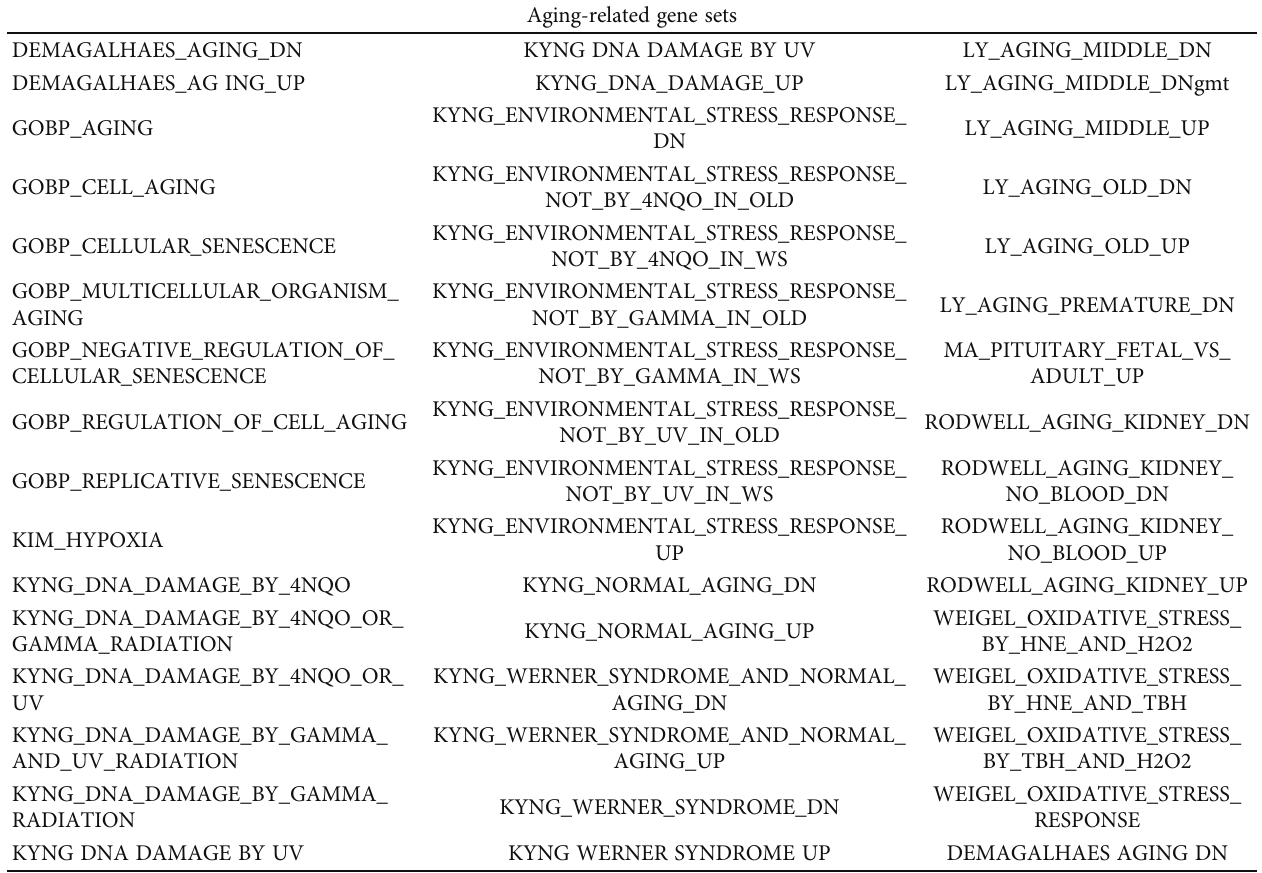
Table 2: Aging-related gene